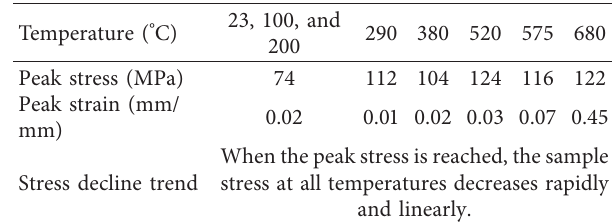
Table 7: Stress-strain relationship of FA geopolymers at different temperatures.